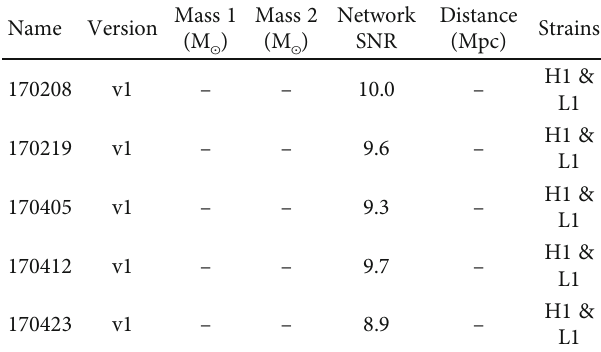
Table 2: The list of GWTC-1-marginal